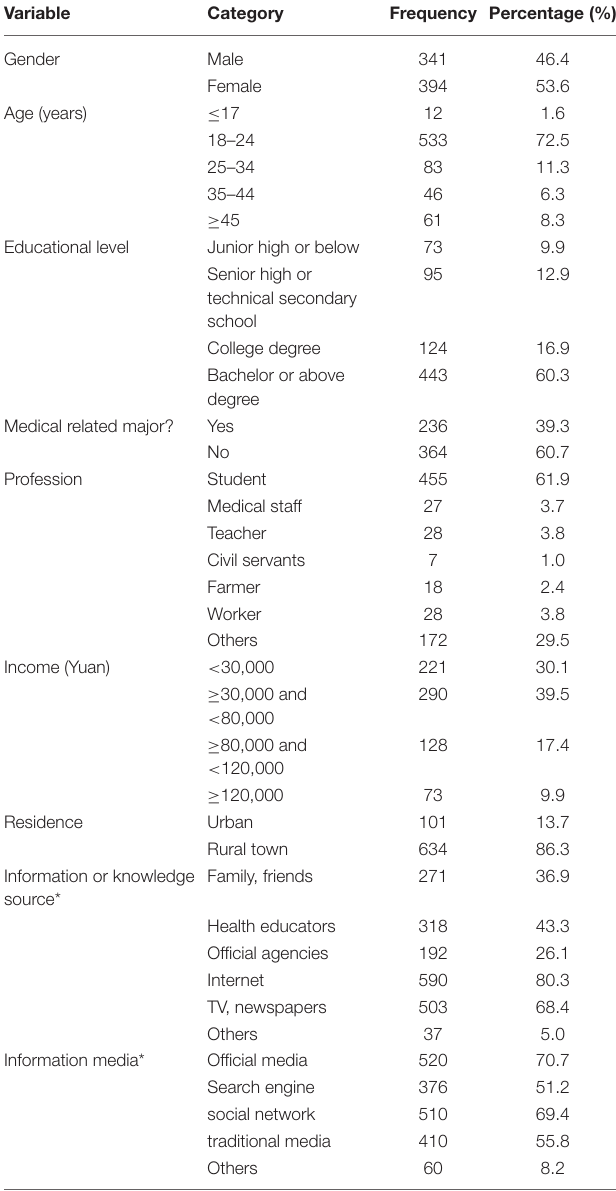
TABLE 1 | Characteristics of